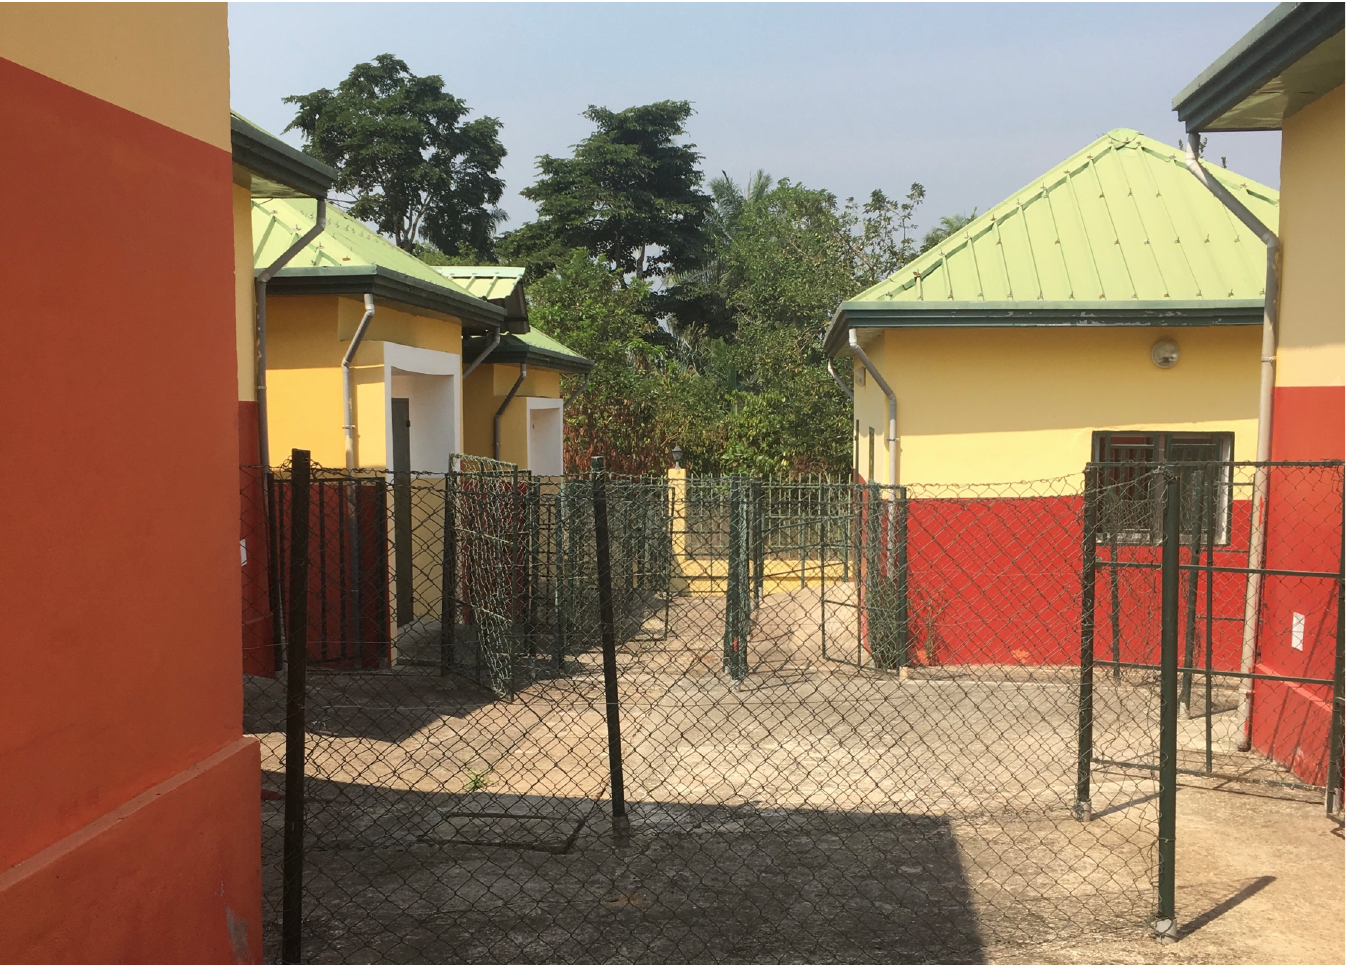
Fig 1. N’Ze´re´kore´ CTEPI, 2019. Photo taken by the author